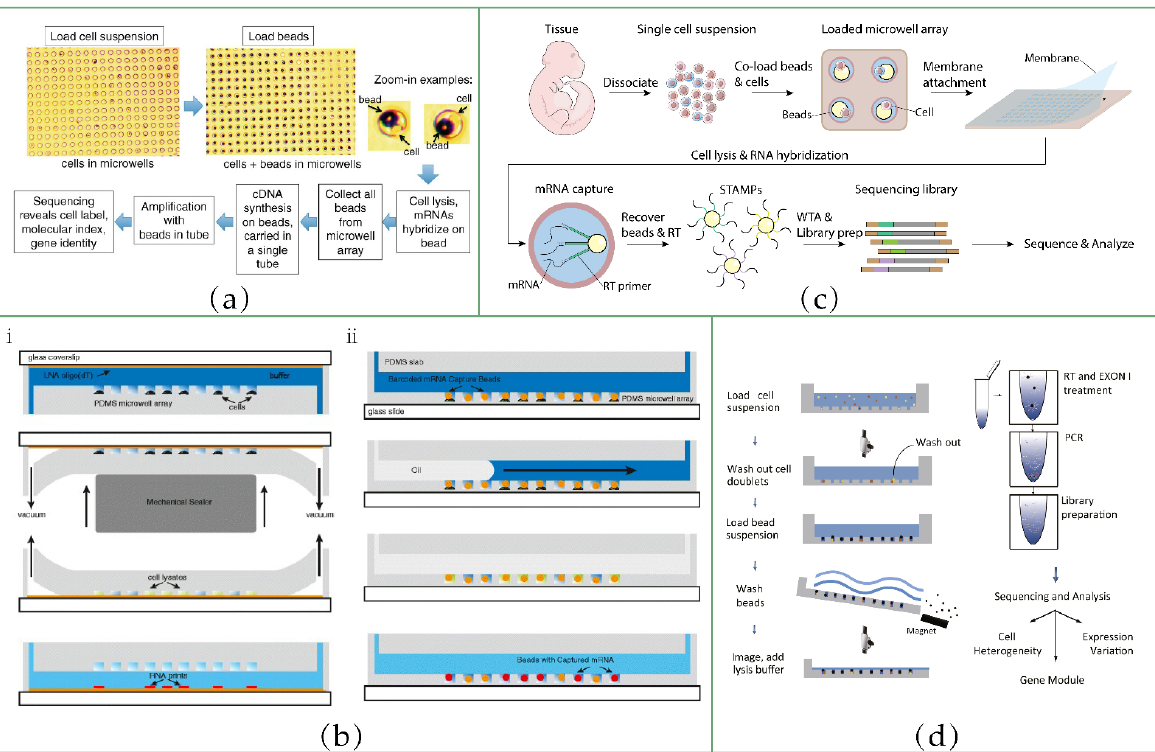
Figure 5. Application of microwell microfluidics in scRNA-seq: Schematic of the workflow of ( a ) CytoSeq. Reprinted from ref. [86]. ( b ) i, single-cell RNA printing; ii, single-cell RNA capture on beads . Reprinted from ref. [87]. ( c ) Seq-Well and ( d ) Microwell-seq . Reprinted from ref. [88].